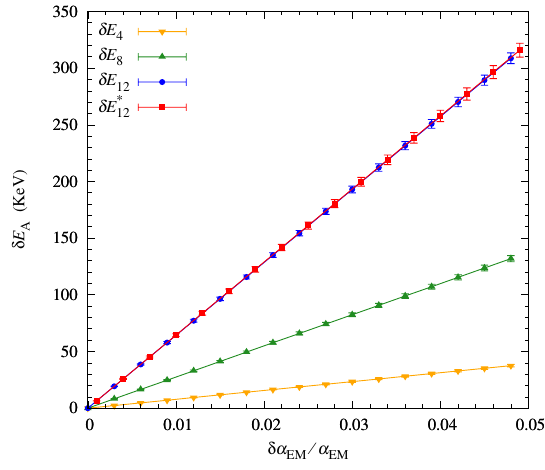
and ¯ A over the range {− 1 , . . . , +1 } . s t